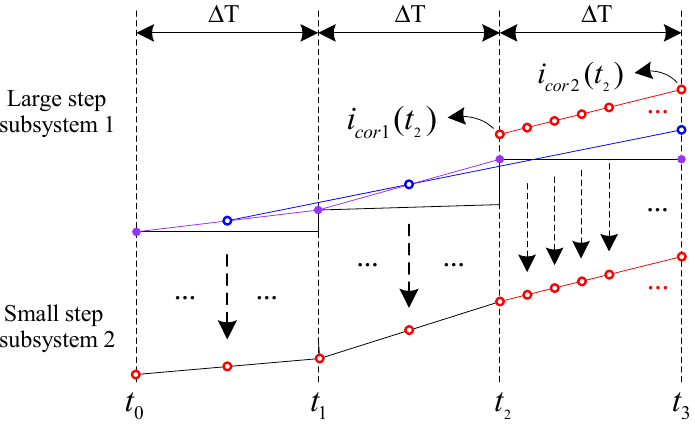
Figure 7. Newton interpolation with small steps. The solid black line of subsystem 1 indicates the actual value of the large-step current, and the corrected values i cor 1 ( t 2 ) and i cor 2 ( t 2 ) at moments ( t 2 + ∆ T ) and ( t 2 + 2 ∆ T ) are obtained by three-point interpolation. The corrected values are advanced one sam- pling step for the interpolation condition, i.e., ( ) i is advanced to moment t . Newton interpolation is performed on the interval cor 2 2 3